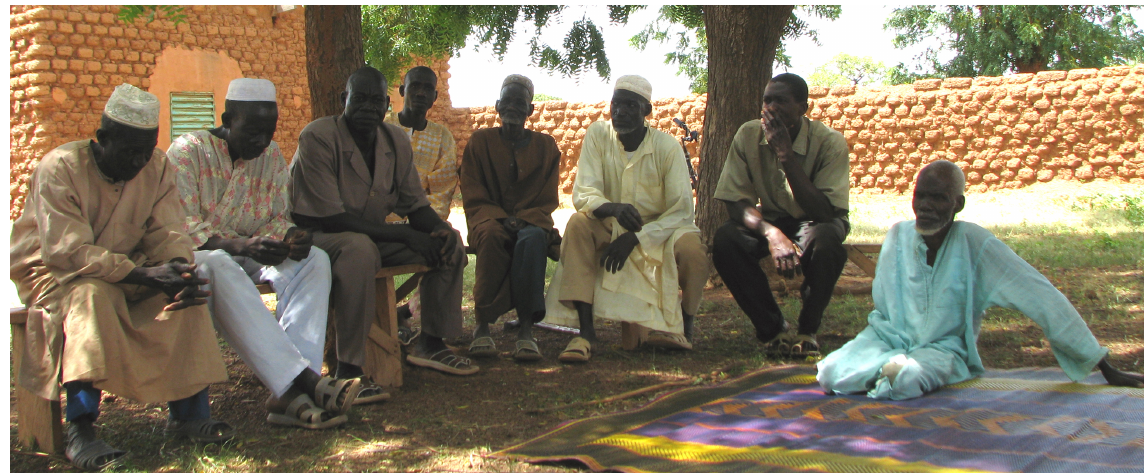
Figure 2. A context analysis visit to the Ranawa village, Burkina Faso, September